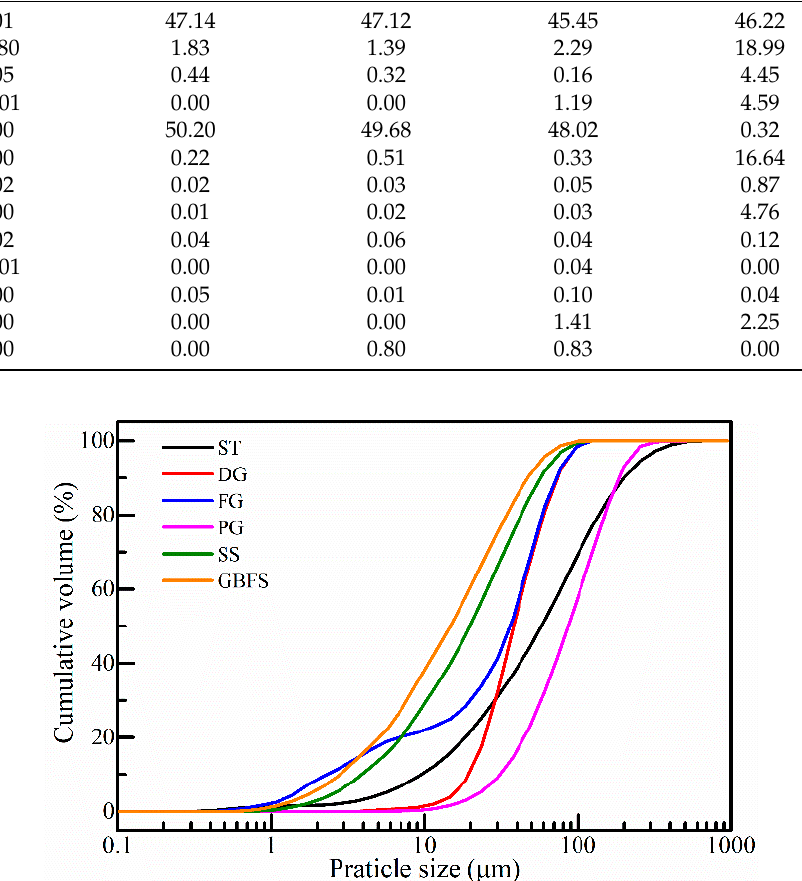
Figure 1. PSD of raw materials used in the experiment.